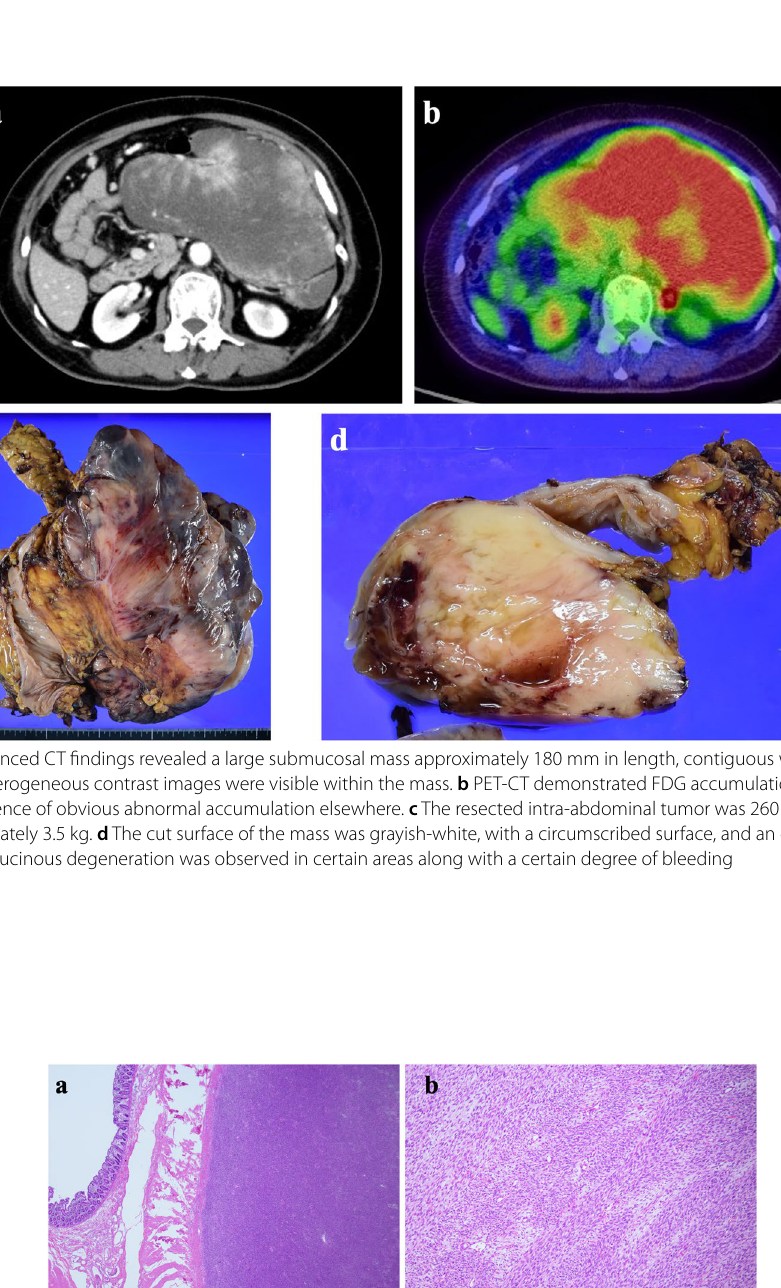
250 120 mm in size × ×